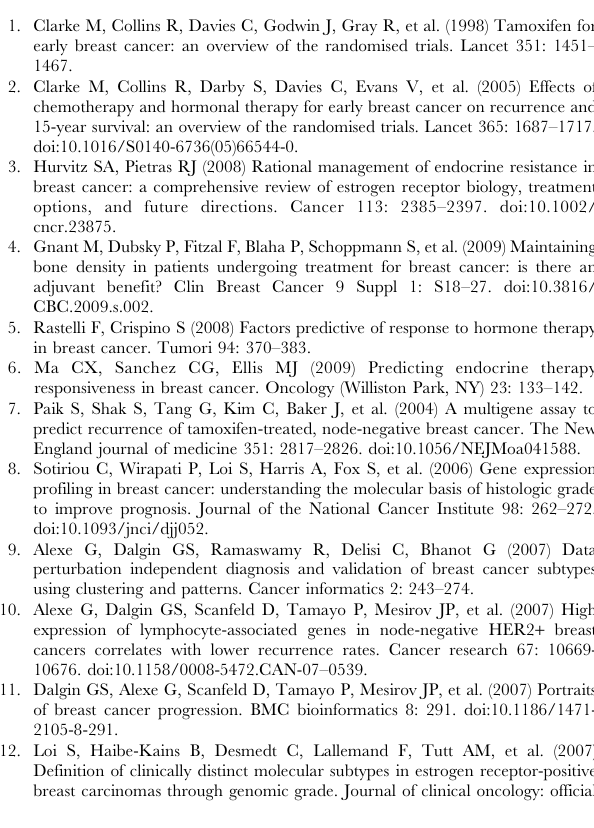
Figure S4 Analysis of amplicon status using FISH in a cohort of tamoxifen treated ER + /HER2 2 breast can- cers. This figure shows typical FISH images from analysis of FFPE slides for samples with/without amplicons using probes specific to each amplicon. Table S1 Clinical information file. Excel 2003 file contain- ing clinical characteristics of the breast tumor samples used in the gene expression analysis from the study by Loi et al. [12,21]. Relative Oncotype Dx scores together with pathway/amplicon presence for each sample are also listed. Table S2 Survival associated with outlier genes. Excel 2003 file containing a table of outlier association results for all genes used in the analysis. Along with the outlier scores and hazard ratios, corresponding P values are also listed. Table S3 Gene patterns associated with tamoxifen response. Gene Ontology pathway/chromosomal location enrichment results in the primary gene expression dataset GSE6532. Significance was assessed using Fisher Exact Test. Table S4 Sample correlations between gene patterns associated with tamoxifen resistance. Sample correlations between cell cycle pathway and amplicons associated with tamoxifen resistance in the primary gene expression dataset GSE6532. Values represent Phi coefficients measuring the strength of association between the group of samples that over- express cell cycle genes and amplicons 17q12, 17q21.33-q25.1, 8p11.2 and 8q24.3. The last column lists the percentage counts of